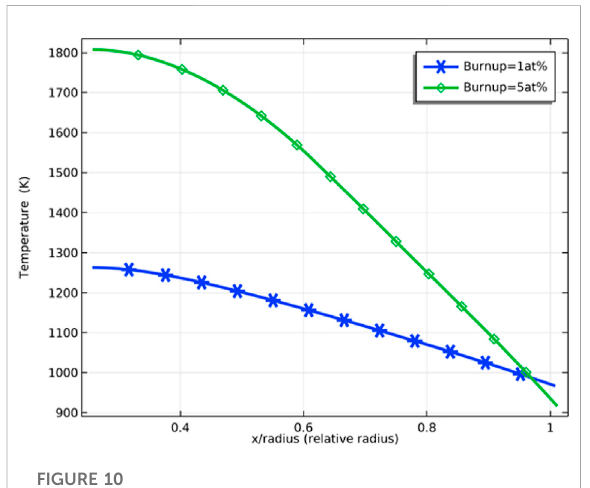
FIGURE 10 Pellet radial temperature for burnup = 1 at% and 5 at%.